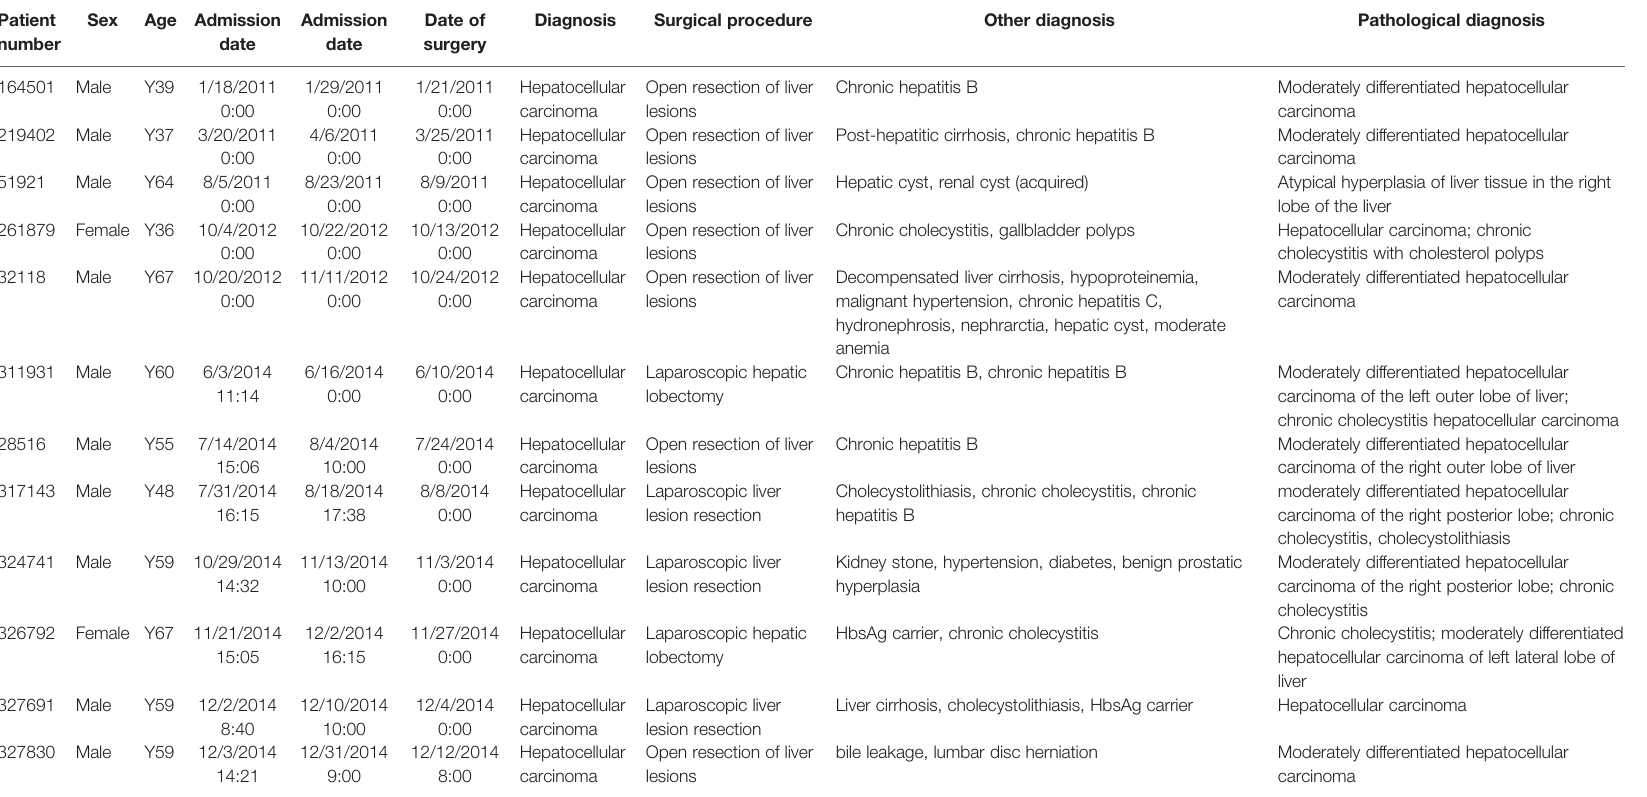
TABLE 1 | The primer sequences used for quantitative real-time PCR. Patient